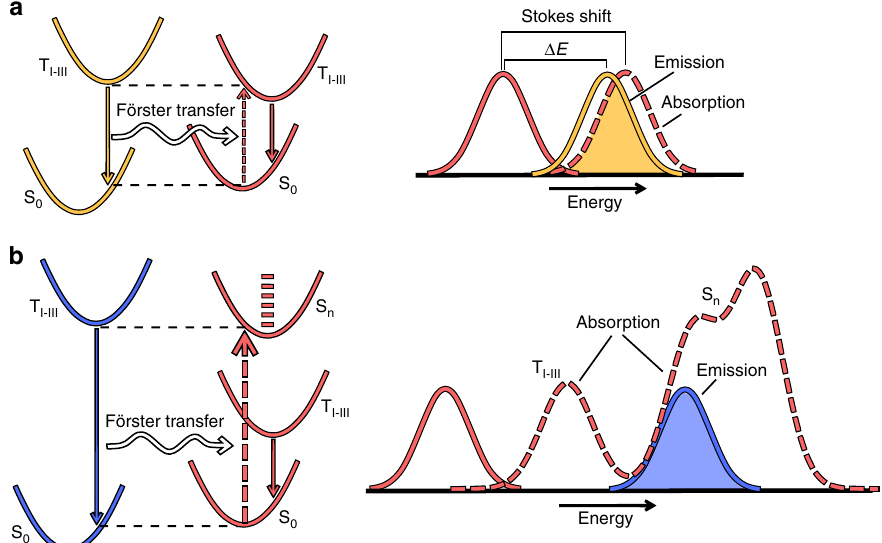
Fig. 1 Schematic depiction of the exothermic Förster transfer mechanism studied in this work. Transfer to emitters with lower emission energy is enhanced by the facts that: ( a ) the lowest-energy states for emission and absorption, which are predominantly of triplet character ( T I − III states), are in resonance due to the Stokes shifts of the donor and acceptor molecules, and ( b ) the excitation can be transferred to energetically higher-lying excited acceptor states. When these states have strong singlet character ( S n ) the transfer can be strongly